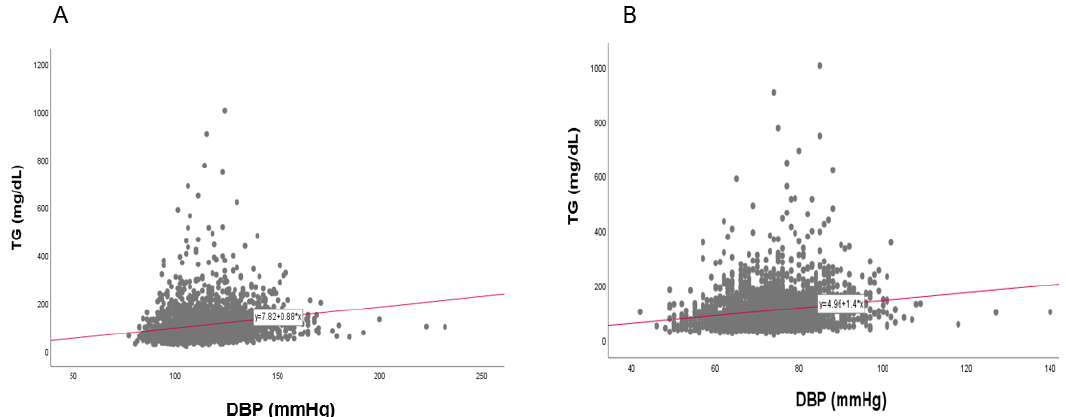
Figure 16. Pearson’s correlation analysis between triglyceride (TG) and diastolic blood pressure (DBP) in men ( A ) and women ( B ). The men (A) showed r = 0.193 ( p < 0.001) and women (B) showed r = 0.180 ( p < 0.001) between DBP and TG.